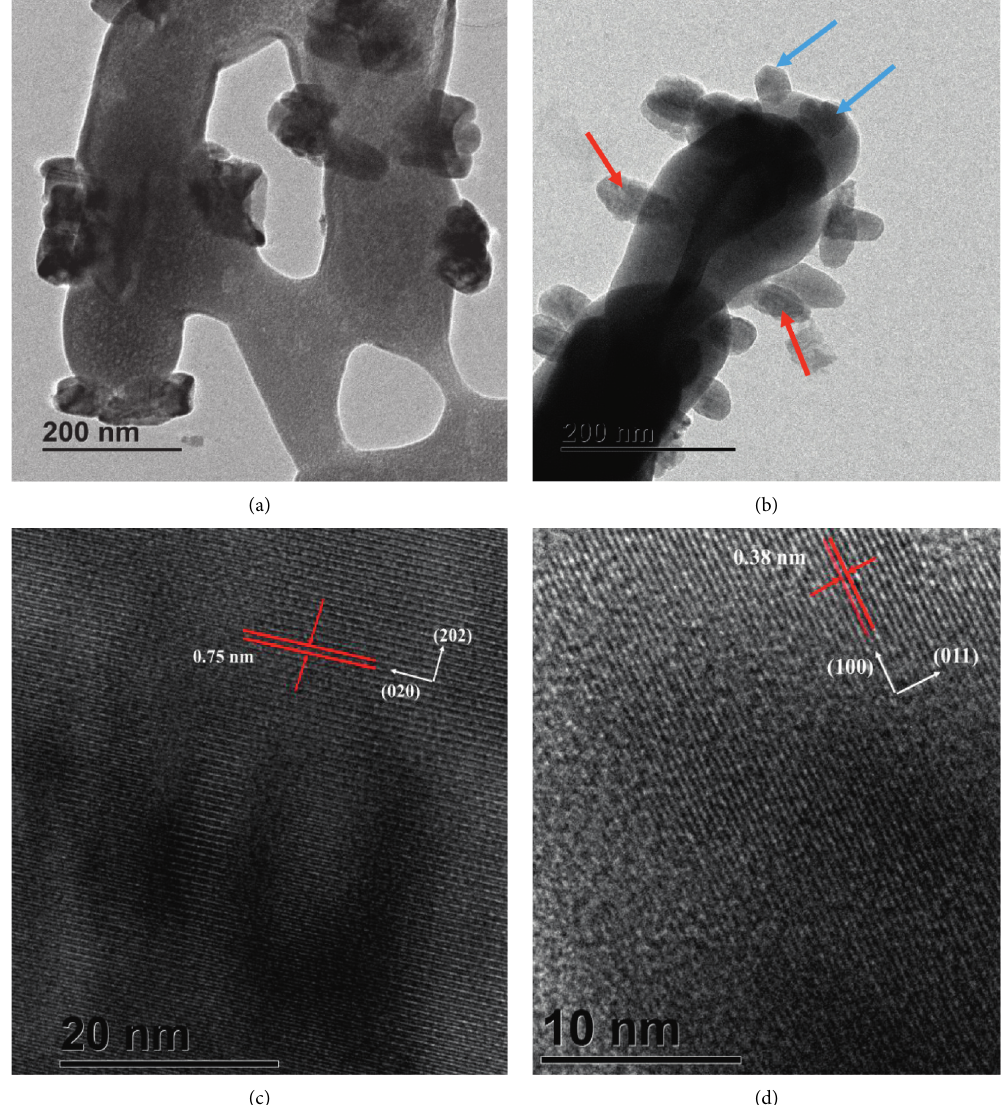
Figure 6: TEM images of (a) BC and (b) HR-TEM images of (c) (020) plane of monoclinic CaAl BaAl 2 O 4